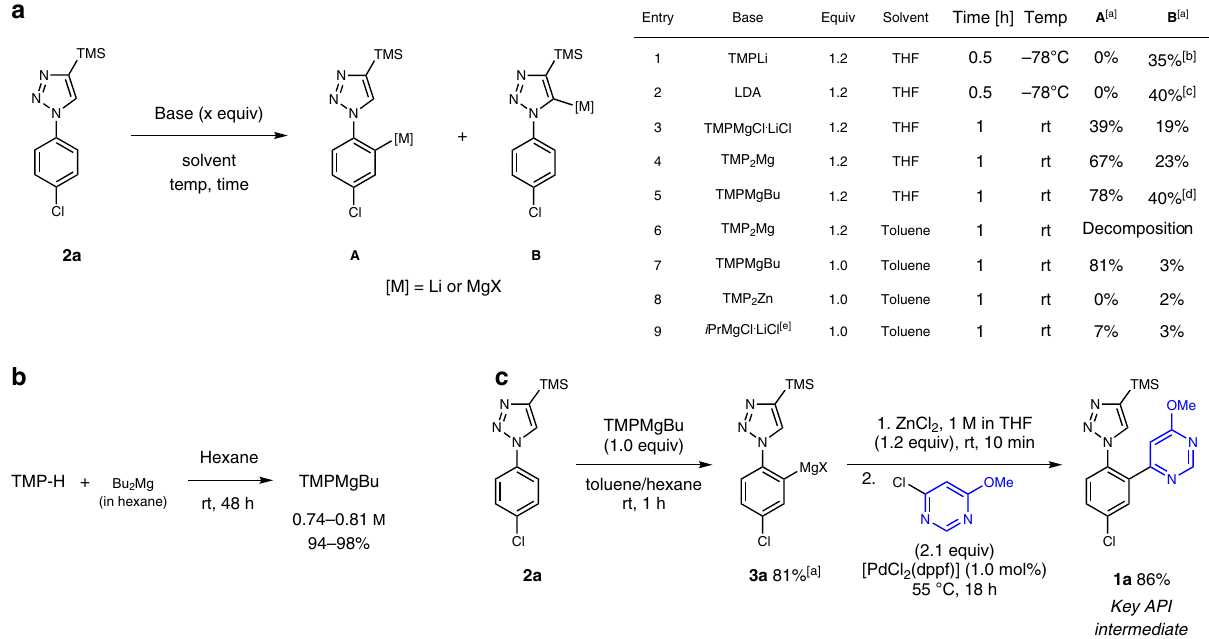
Fig. 2 Reaction optimization. a Screening of the metalation of 2a . [a] Metalation yields were determined by 1 H-NMR analysis of D 2 O-quenched reaction aliquots. [b] Sixty- fi ve percent decomposition. [c] Forty-three percent decomposition. [d] Including bis-metalated species. [e] In THF. b Preparation of TMPMgBu. c Pd-catalyzed cross-coupling reaction towards 1a